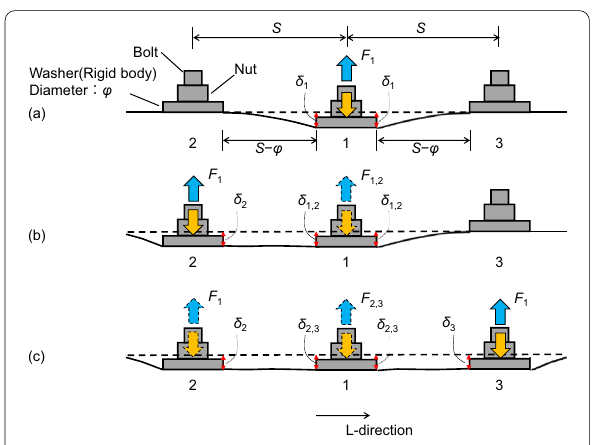
Fig. 6 Diagram of deformation when tightening bolts. ( a ) When bolt 1 is tightened, ( b ) When bolt 2 is tightened, ( c ) When bolt 3 is